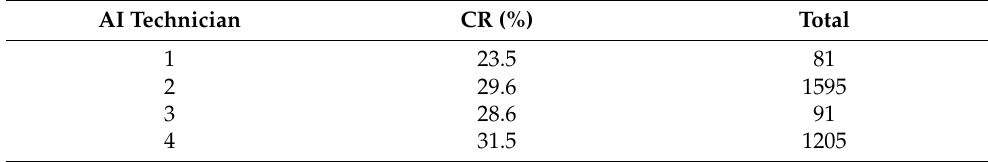
Table 4. Conception rates (in %) and number of AI performed by the different AI technicians.